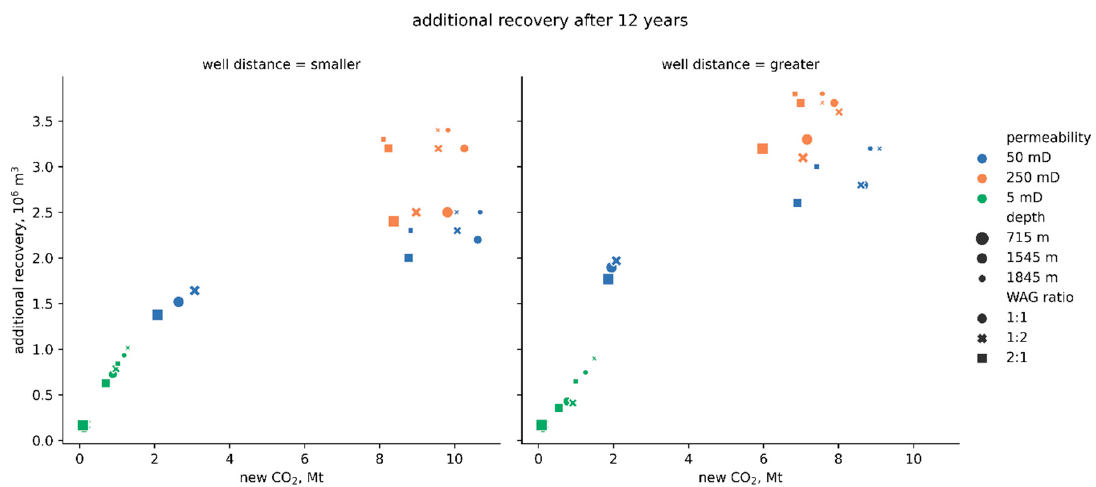
Figure A8. Additional recovery versus new CO 2 after 12 years of EOR.